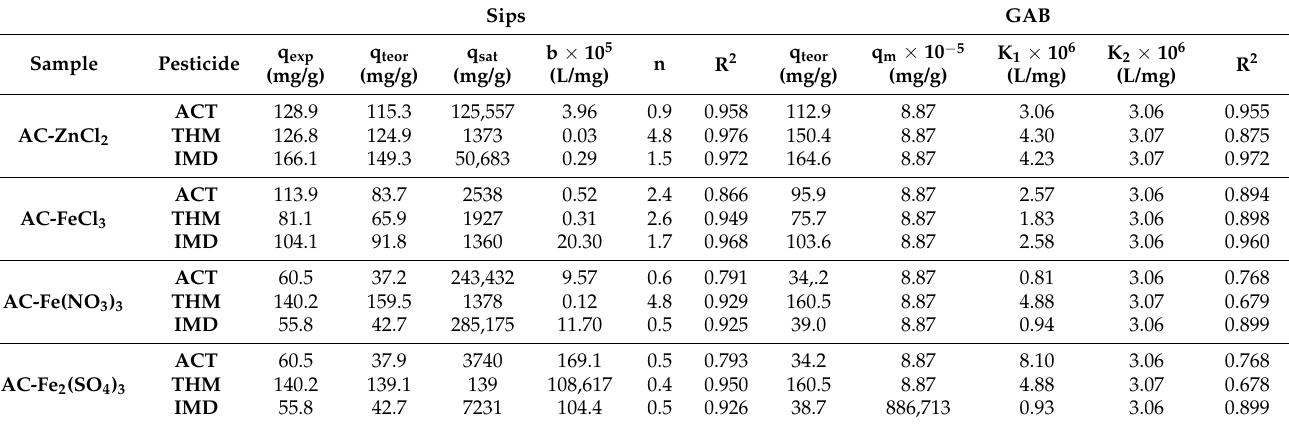
Table 6. Isotherm model parameters for the adsorption of ACT, THM, and IMD onto the carbon materials: the Sips and Guggenheim–Anderson–De Boer (GAB)